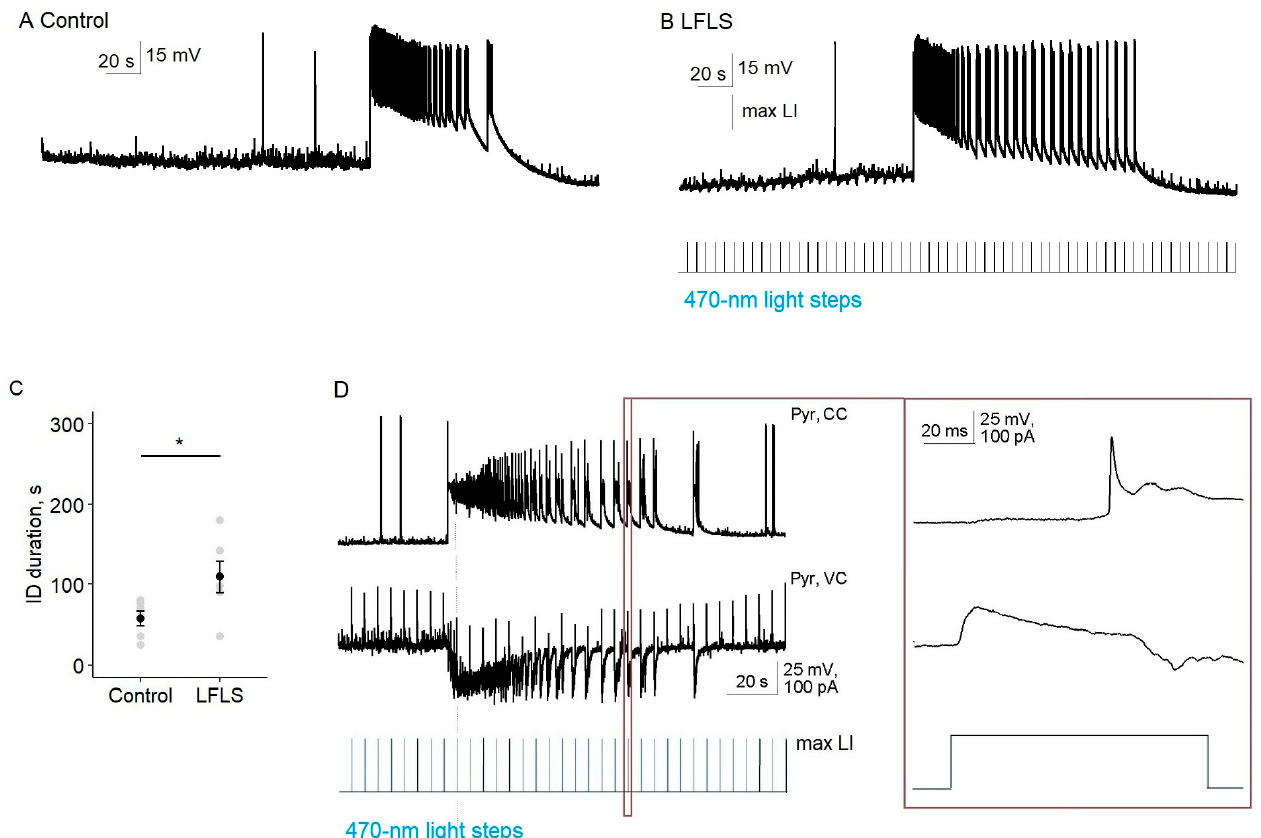
Figure 5. LFLS of parvalbumin interneurons in the entorhinal cortex of Model 2 did not stop ictal activity and prolonged its clonic phase. ( A , B ) Ictal discharges shown with spiking activity of a representative pyramidal cell in the control group ( A ) and during LFLS ( B ). ( C ) Statistical data for the duration of spiking activity during ictal discharge (ID duration, * p < 0.05, paired t -test, n = 6). ( D ) Representative simultaneous recording of spiking activity of one pyramidal cell and postsynaptic currents in another at the holding potential of − 27 mV during LFLS. One scaled response to a light flash is shown in the right panel.